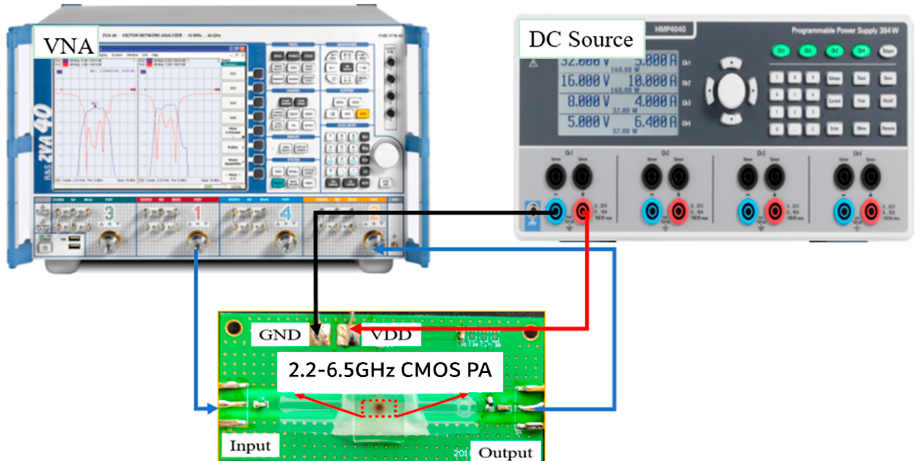
Figure 4. Schematic diagram of the experimental environment.